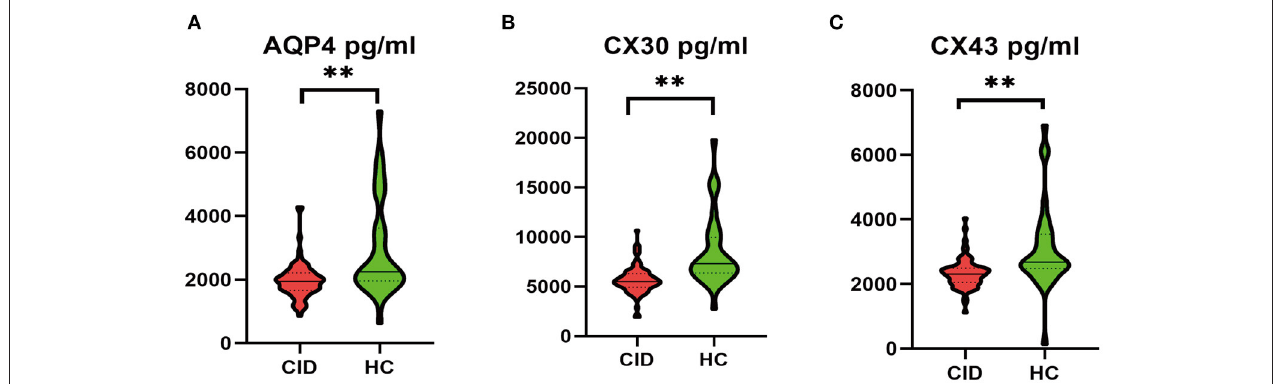
FIGURE 2 | Comparison of serum protein levels between CID patients and HCs. ** P < 0.01. AQP4, aquaporin-4; CID, chronic insomnia disorder; CX30, connexin 30; CX43, connexin 43; HC, healthy control.